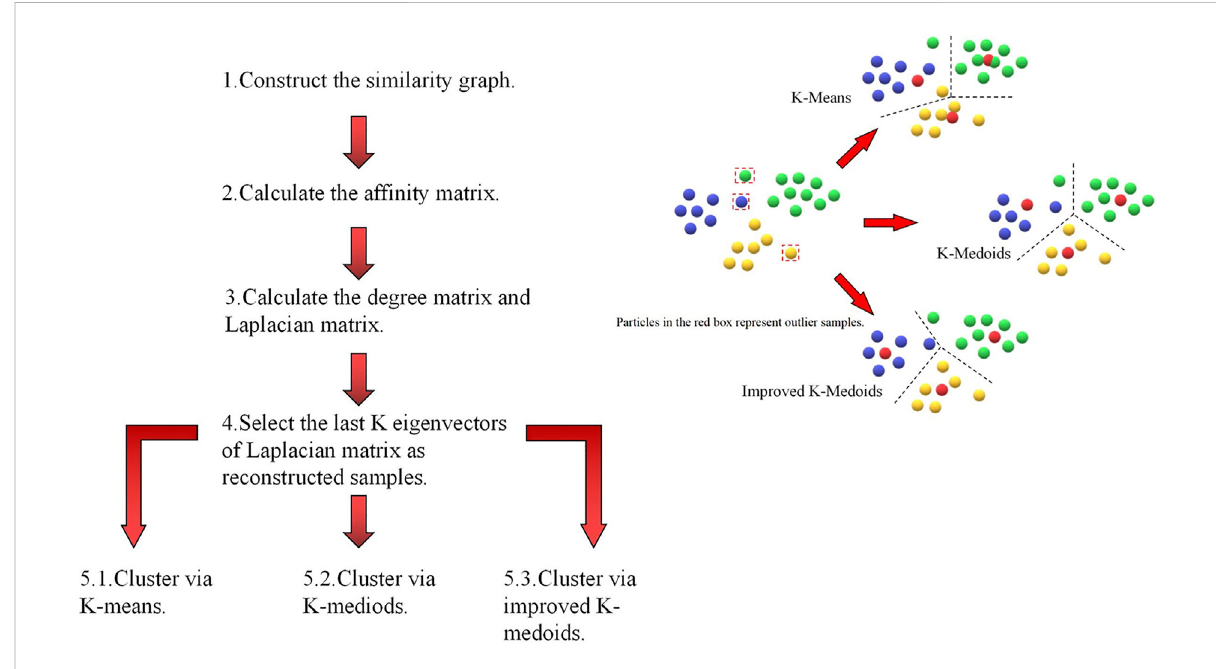
FIGURE 2 Comparison of proposed spectral clustering fl ows and original spectral clustering fl